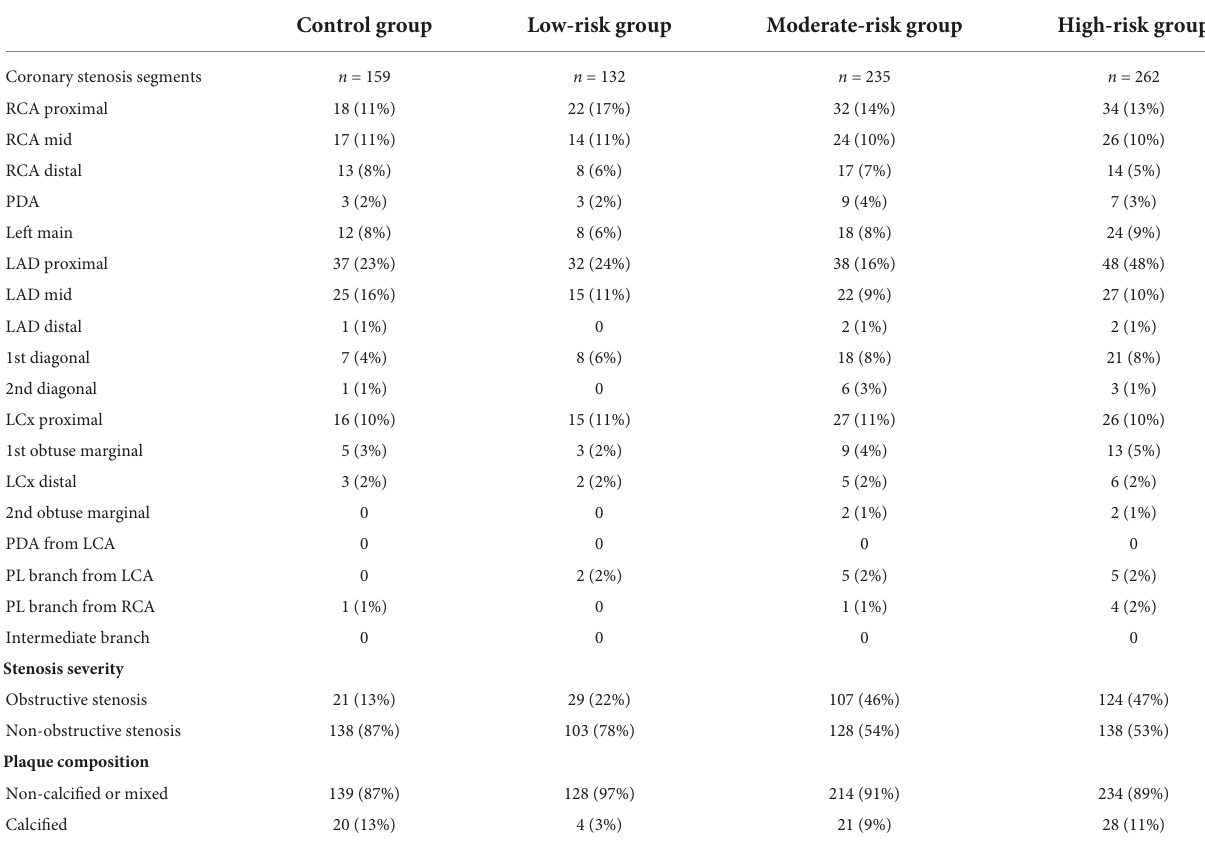
TABLE 5 Coronary stenosis segments in different groups.